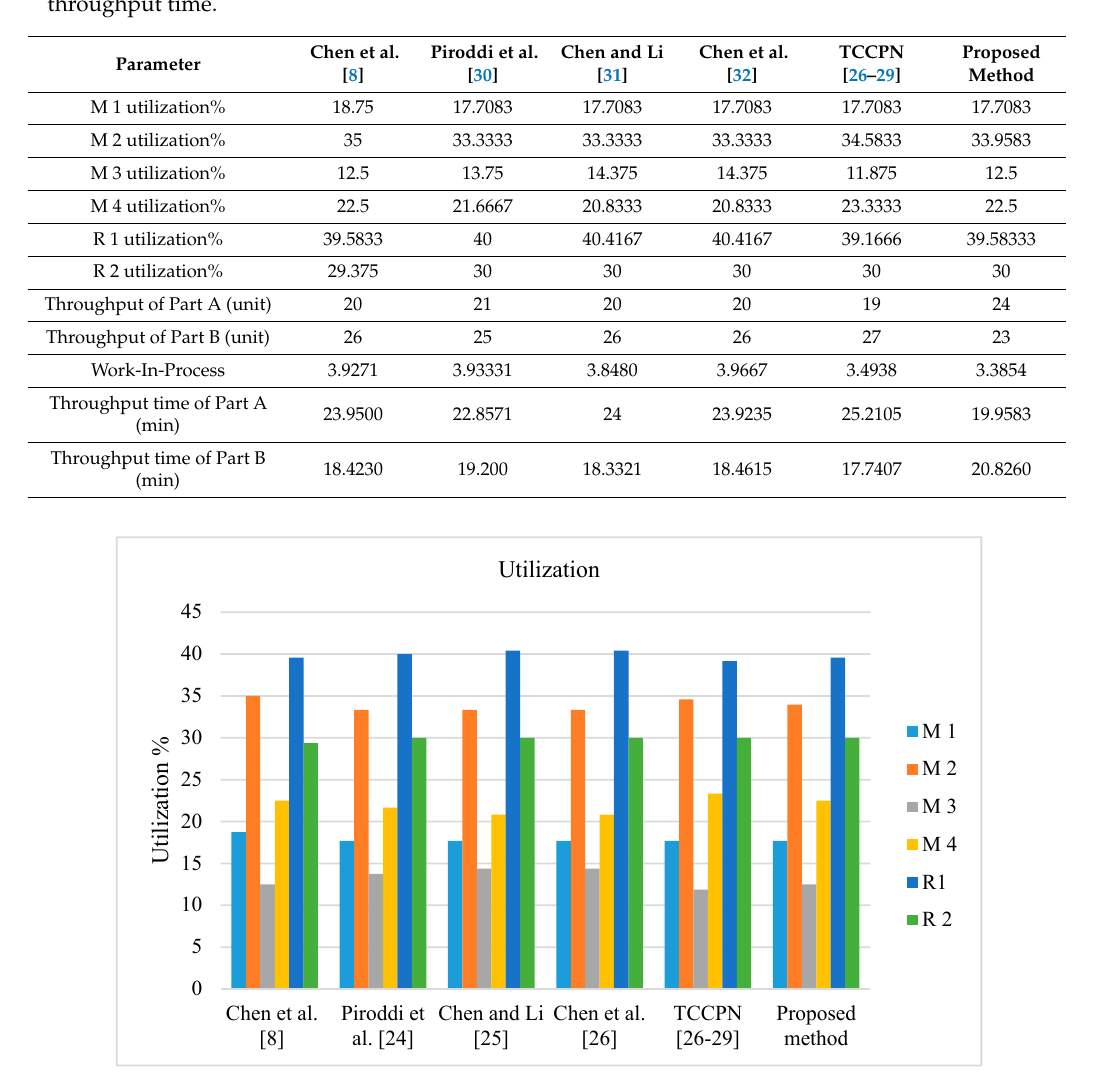
Figure 12. Comparison of utilization for the Petri net model from Figure 11.